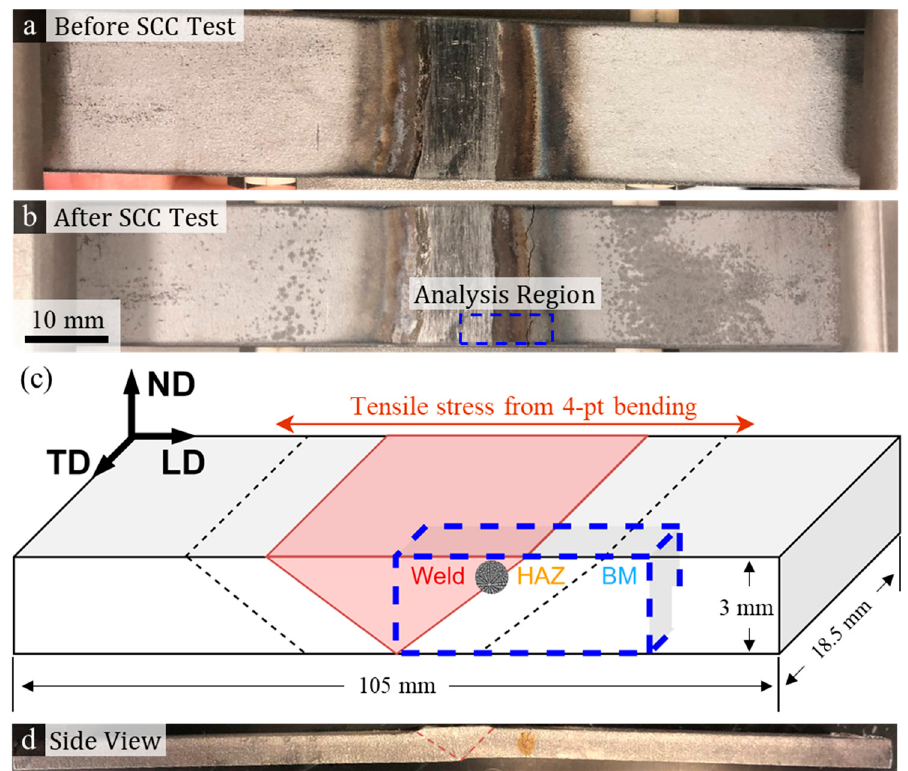
Figure 1. ( a , b ) Surface morphology of test coupon before and after immersion in boiling magnesium chloride; ( c ) schematic illustration of the coupon dimension and welding zones; ( d ) side view of the test coupon after boiling magnesium chloride immersion, with a major crack appearing to the right of the weld seam (adapted from Reference [27]).